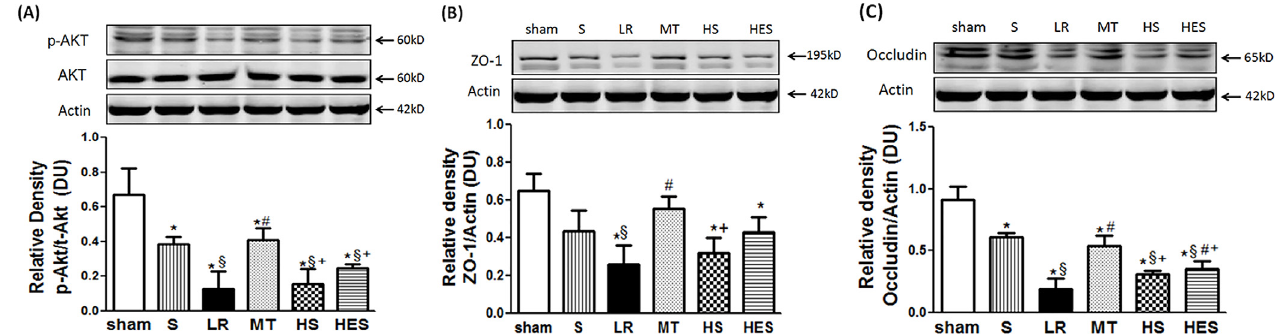
Fig 8. Expression of total and phosphorylated protein kinase B (p-Akt) and tight junction proteins in intestine between groups. The intestinal sample extracts were immunoblotted for the expression of phosphorylated (p)-Akt, total (t)-Akt, ZO-1 and occludin. Representative images of the Western blots are shown (A). Expression of p-Akt and t-Akt among groups (B); Expression of ZO-1 among groups; (C). Expression of occludin among groups. Data are presented as means ± S.E.M., n = 8 in each group. Data are presented as means ± S.E.M., n = 8 in each group. * P < 0.05 in comparison with the sham group, § P < 0.05 in comparison with the S group, # P < 0.05 in comparison with the LR group, + P < 0.05 in comparison with the MT